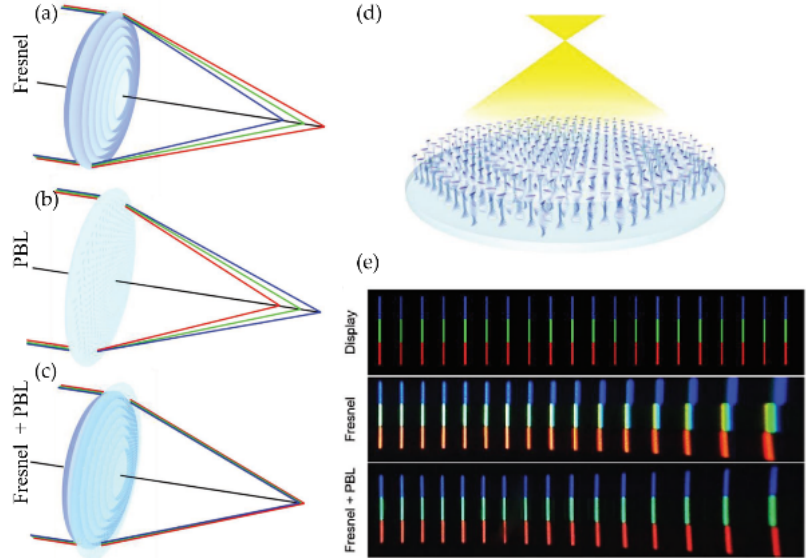
Figure 7. Schematic drawing of chromatic aberrations (CAs) in ( a ) a refractive Fresnel lens, ( b ) a diffractive Pancharatnam-Berry lens (PBL) and ( c ) the hybrid lens. ( d ) Schematic illustration of a CA lens. ( e ) Half-field CA testing (RGB pixels of LCD) [11]. Copyright 2019, WILEY - VCH.